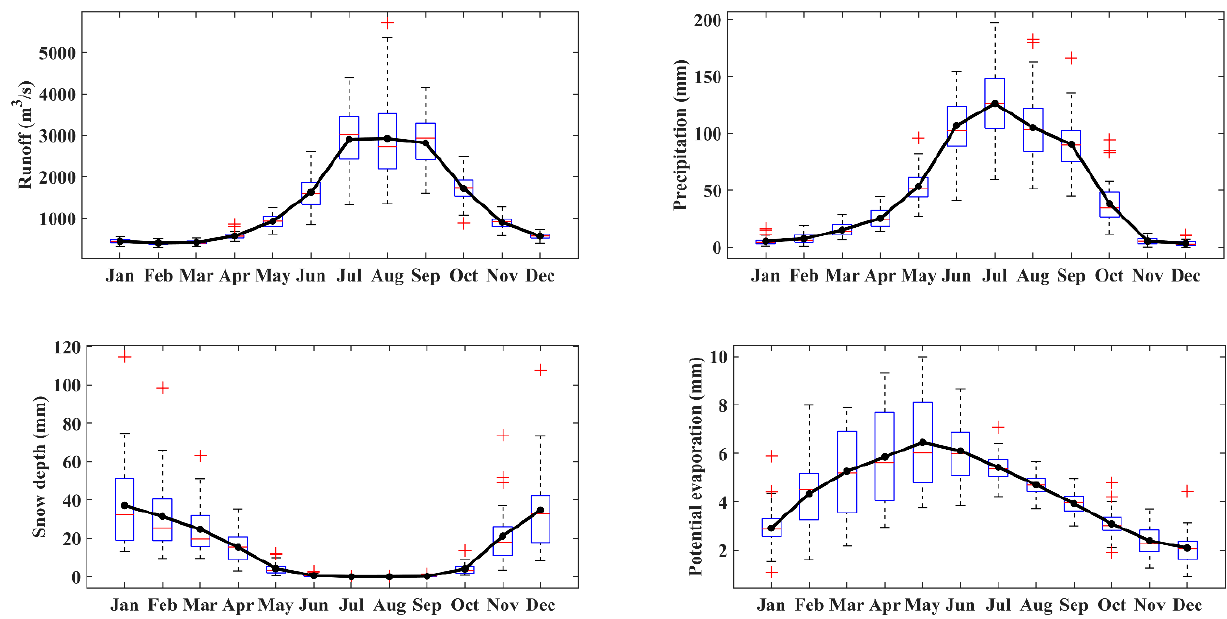
Figure 2. Seasonal variation characteristics of water resources in the upper reaches of Jinsha River. (The thick black solid line indicates the multi-year average. The blue box in the boxplot indicates the upper and lower quartile interval, the short red line indicates the median, the short black line indicates the outlier cutoffs and the red plus sign indicates the outlier).